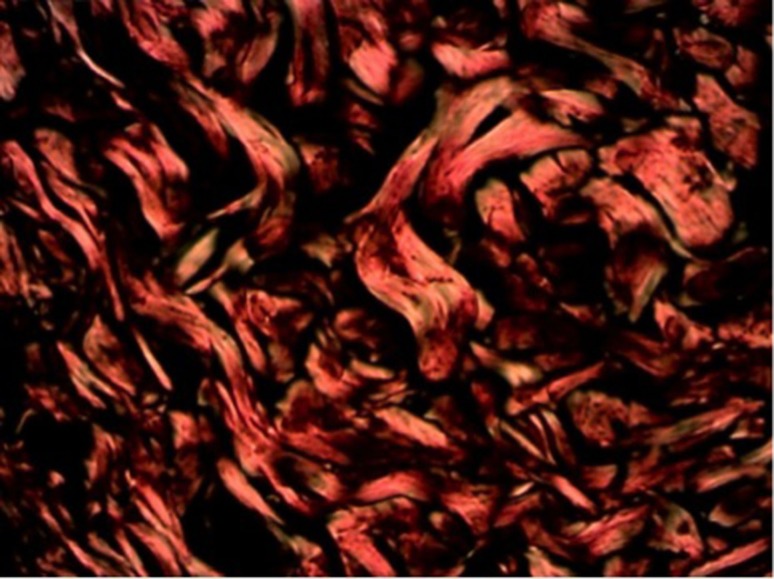
Picrosirius staining for control group/14 day subset.